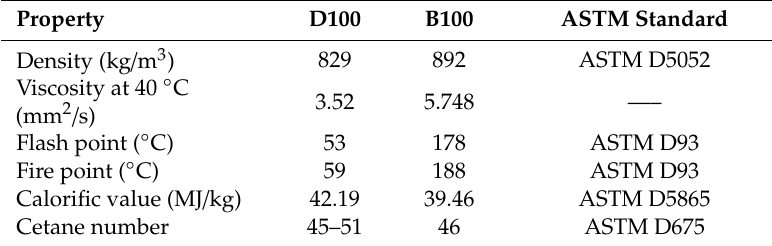
Table 1. Specification of tested fuels.